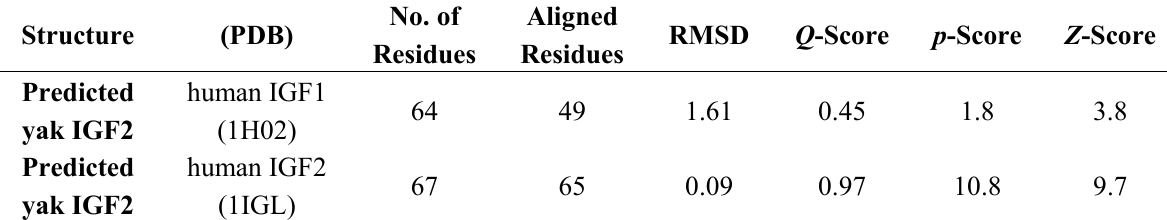
Table 3. Pairwise alignment between predicted structure of Tianzhu white yak IGF2 and Homo sapiens IGF2 and IGF1 . RMSD (root mean square deviation), PDB (protein data